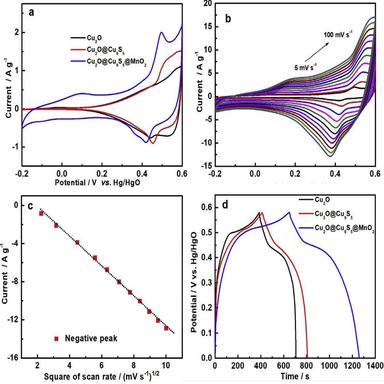
(a) CV curves of Cu2O, Cu2O@Cu9S5 and Cu2O@Cu9S5@MnO2 in 1.0 M KOH solution at a scan rate of 5 mV s1 ; (b) CV curves of Cu2O@Cu9S5@MnO2 in 1.0 M KOH solution at different scan rates; (c) corresponding plots of reduction peak densities versus the square root of scanning rate; (d) Galvanostatic charge-discharge curves of the three electrodes at 0.1 A g1 .